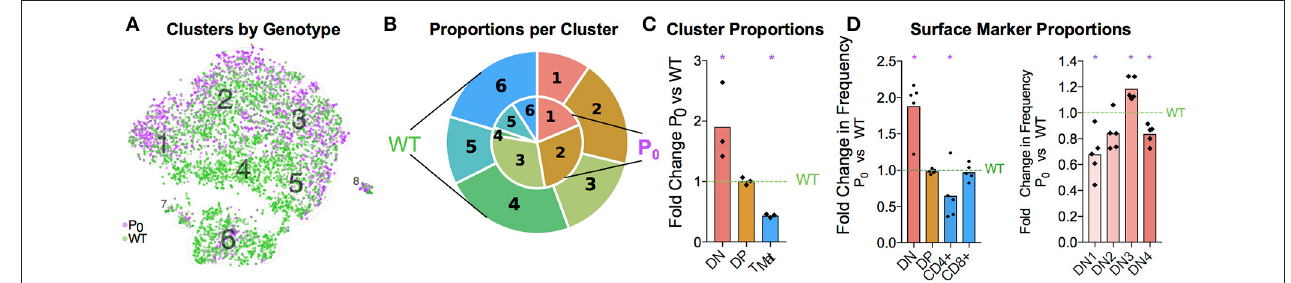
FIGURE 6 | FGR Leads to T-Cell Differentiation Delay. (A) Single-cell map colored by genotype with previous cluster numbering. Red: P 0 , 2,585 cells, n = 3. Teal: WT, 4,679 cells, ( n = 4). (B) Visual representation of the proportions of cells in each genotype per cluster, averaged from each trial and labeled for each cluster. Clusters are labeled by number, from the DN T-cell stage in Cluster 1 to T Mat in Cluster 7. P 0 is in the inner circle, while WT is in the outer circle. (C) Proportions of cells within each cell population as determined by Drop-Seq were compared to WT levels. (D) Cells were classified by their surface markers using flow cytometry as DN, DP, CD4 + , or CD8 + cells and proportions were compared with littermate controls ( n = 9, 5). Within the DN population, cells were classified from DN1 to DN4 based on their CD25 and CD44 status. These proportions were then compared with littermate controls. Comparisons were calculated using Student’s t -test with the exception of the Cluster 5 (C) , DN, and DN3 (D) subsets, which failed to pass the Shapiro-Wilk test for normality and were instead analyzed using Mann-Whitney Rank comparison tests (* P <